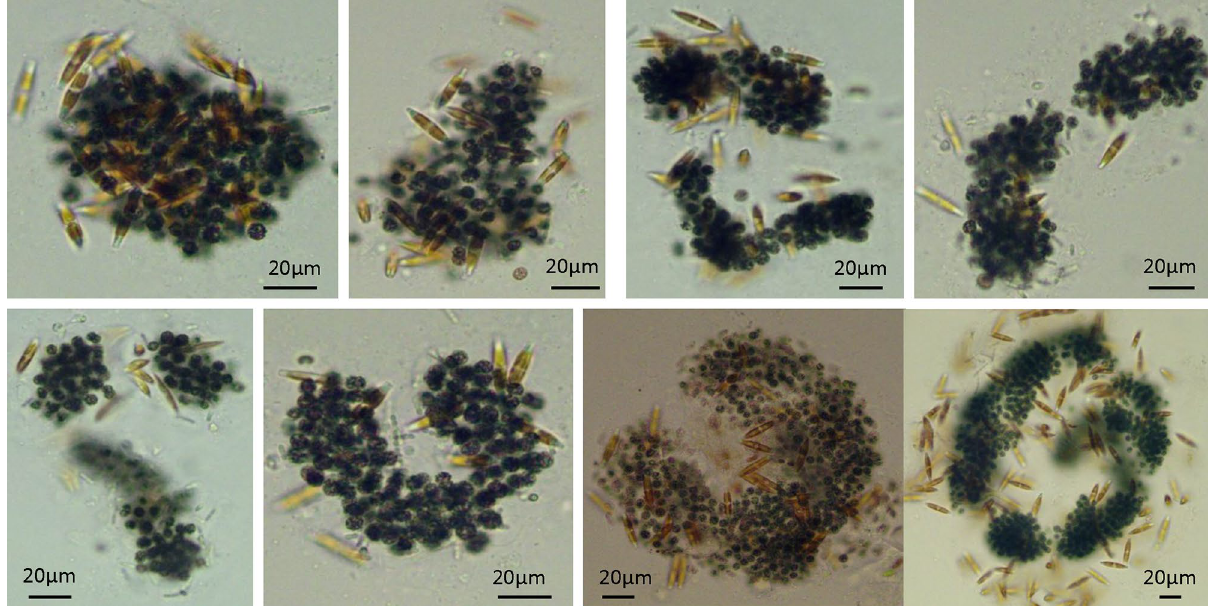
Figure 3. Pictures of the Nitzschia palea, a diatom attached to the Microcystis colonies in treatment Low on day 20.